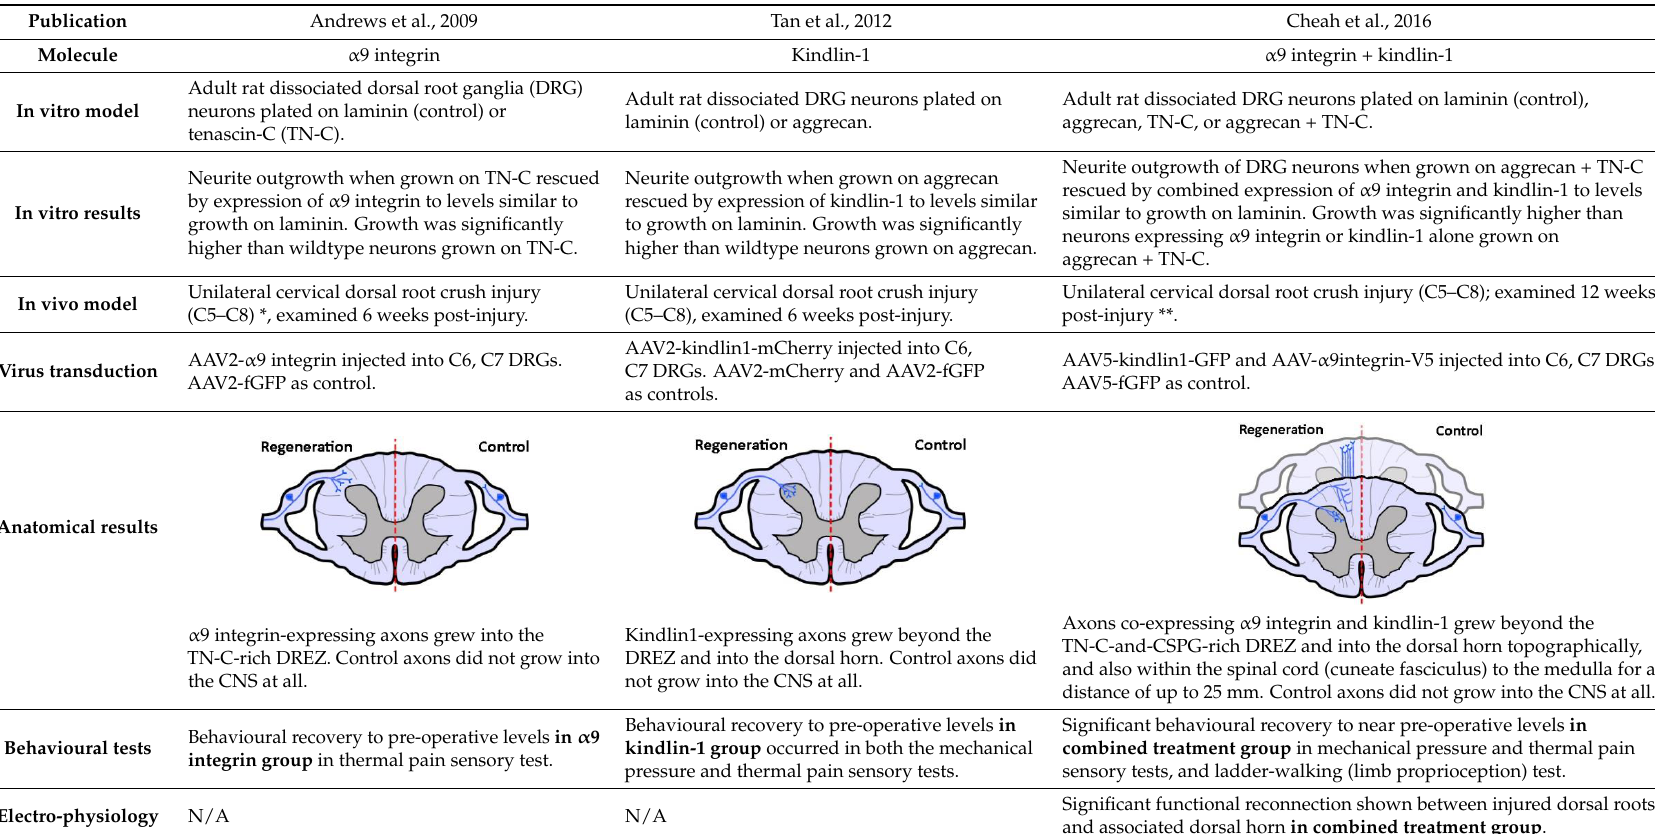
Table 1. Summary of integrin-mediated dorsal column axon regeneration.